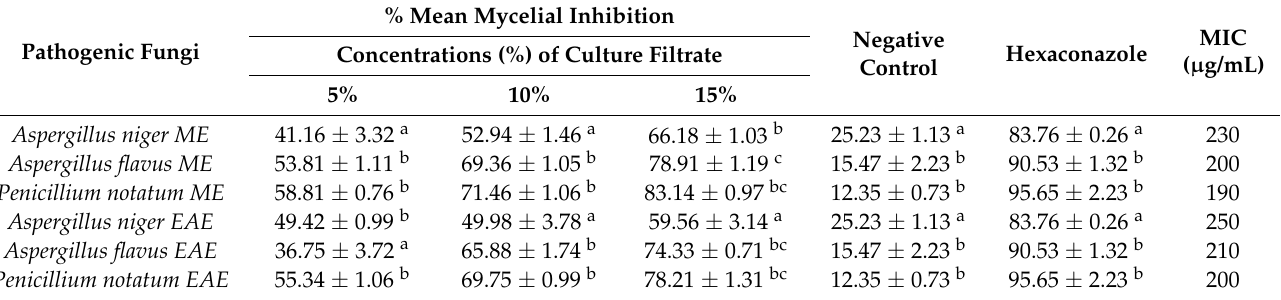
Table 7. Antifungal activity (percentage mycelial inhibition) of rhizome extracts of A. chasmanthum .